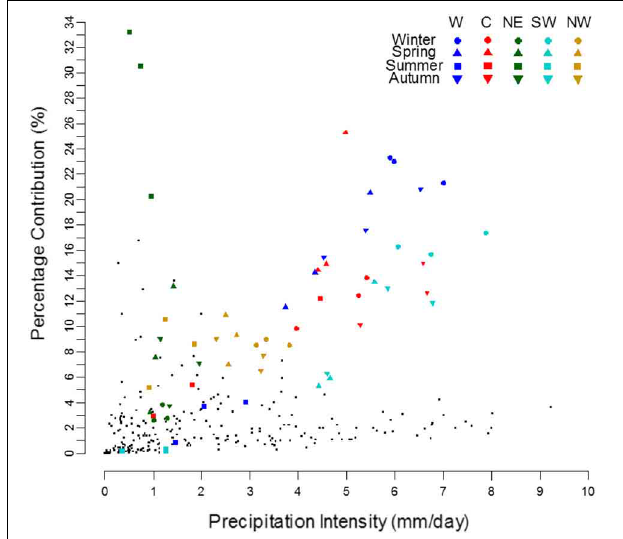
FIGURE 10 | Similar to Figure 9 but for Percentage Contribution vs. Precipitation